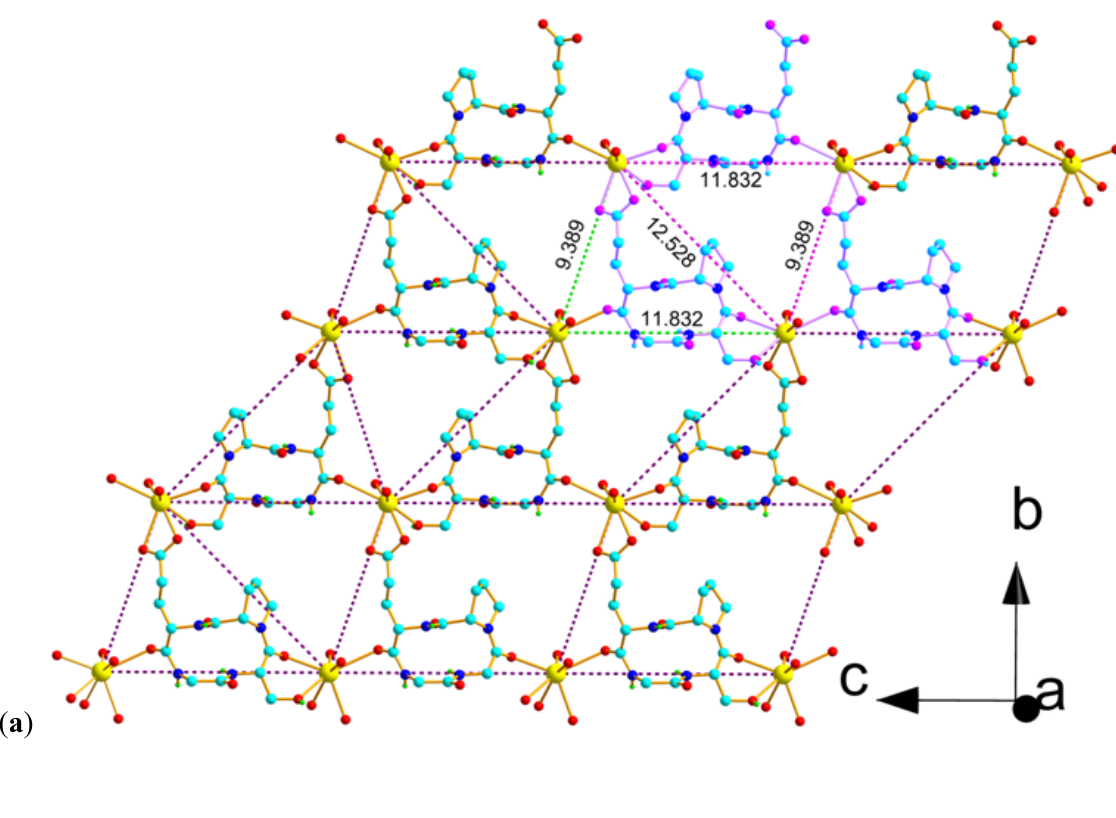
Figure 4. ( a ) Perspective view of 2D-network along a-axis. Color code: yellow, Pb; cyan, C; blue, N; red, O. ( b ) 2D sheet of 2 in the bc plane. Color code: green, Pb; gray, C; blue, N; red,